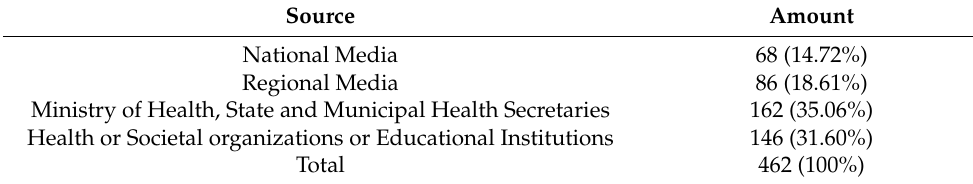
Table 3. Source of news